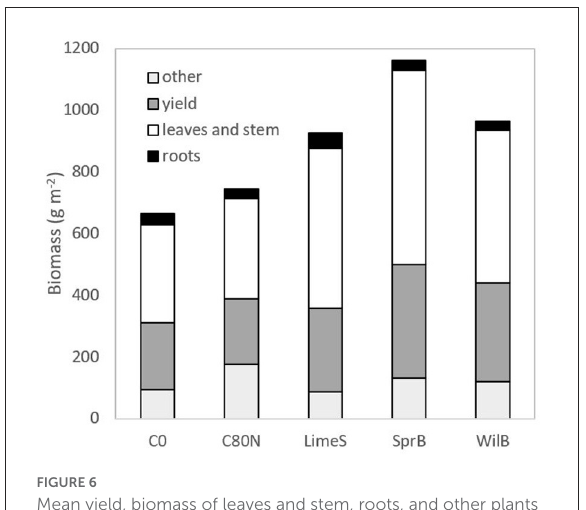
FIGURE6 Mean yield, biomass of leaves and stem, roots, and other plants (weeds) as dry mass in the different treatment plots. Different letters indicate significant difference in the fluxes between the measured species ( P <